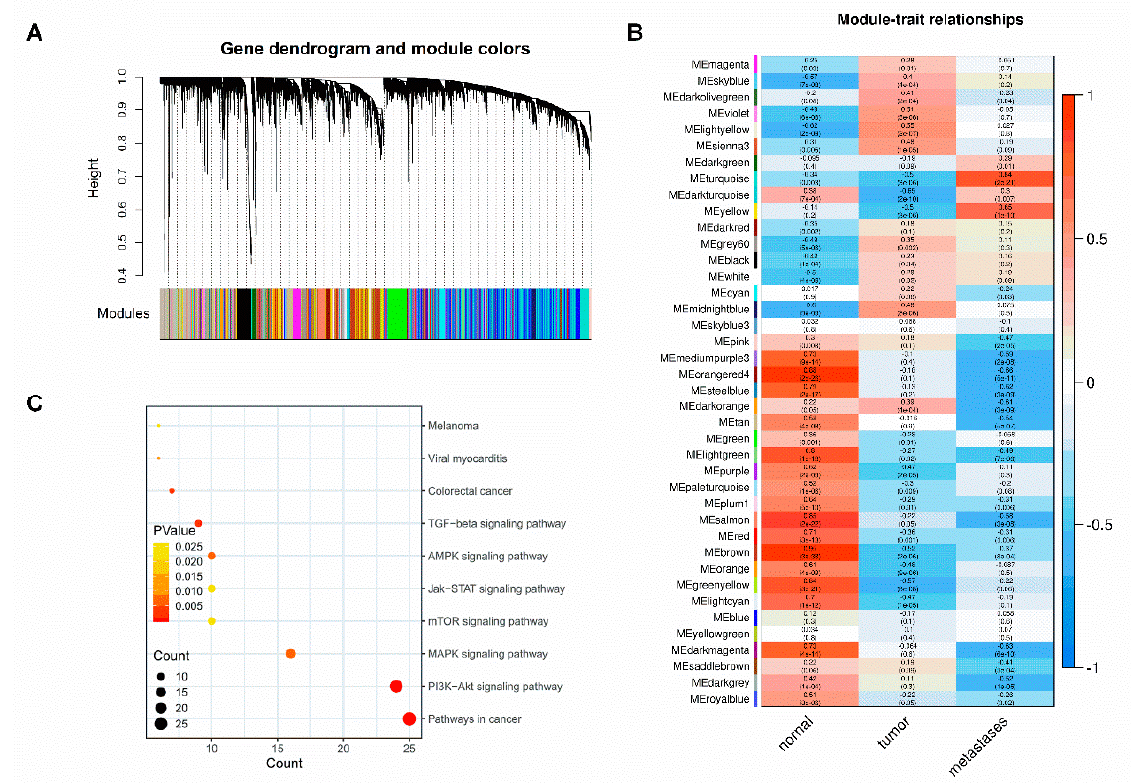
Figure 2. Identification of modules associated with clinical information, and pathways associated with metastasis. ( A ). Dendrogram of all expressed genes clustered based on a dissimilarity measure (1-TOM). The upper presents the clustering dendrogram of genes and the lower presents the assigned module colors. ( B ) Heatmap of module-trait correlations. Each cell describes the correlation coefficients and p -value. The cells are colored by the intensity of correlation, red for positive correlation and blue for negative correlation. The turquoise module was identified as trait-related modules for metastasis. ( C ). Kyoto Encyclopedia of Genes and Genomes (KEGG) enrichment analysis of genes in turquoise module. The depth of color corresponds to the enrichment significance, the size of the circle indicates the enriched gene count.